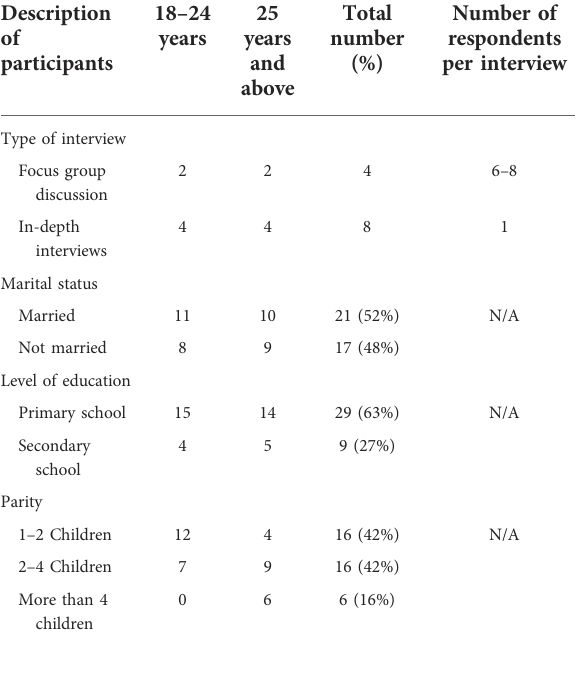
TABLE 1 Background information of participants.